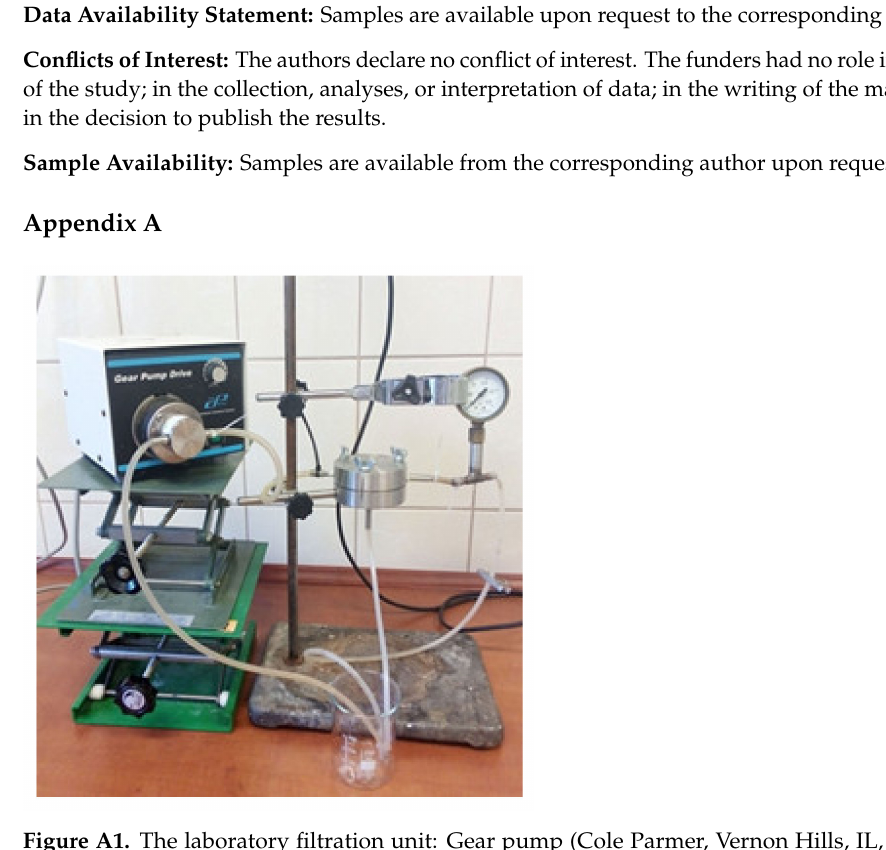
Figure A1. The laboratory filtration unit: Gear pump (Cole Parmer, Vernon Hills, IL, USA), steel module for membrane, and monometer. Pressure is generated by throttling.